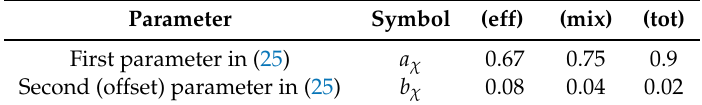
Table 9. Calibrated values for the generalized Bishop parameter in equation (25) for the original effective stress formulation (eff), for the mixed stress formulation (mix), and for the total stress formulation (tot).